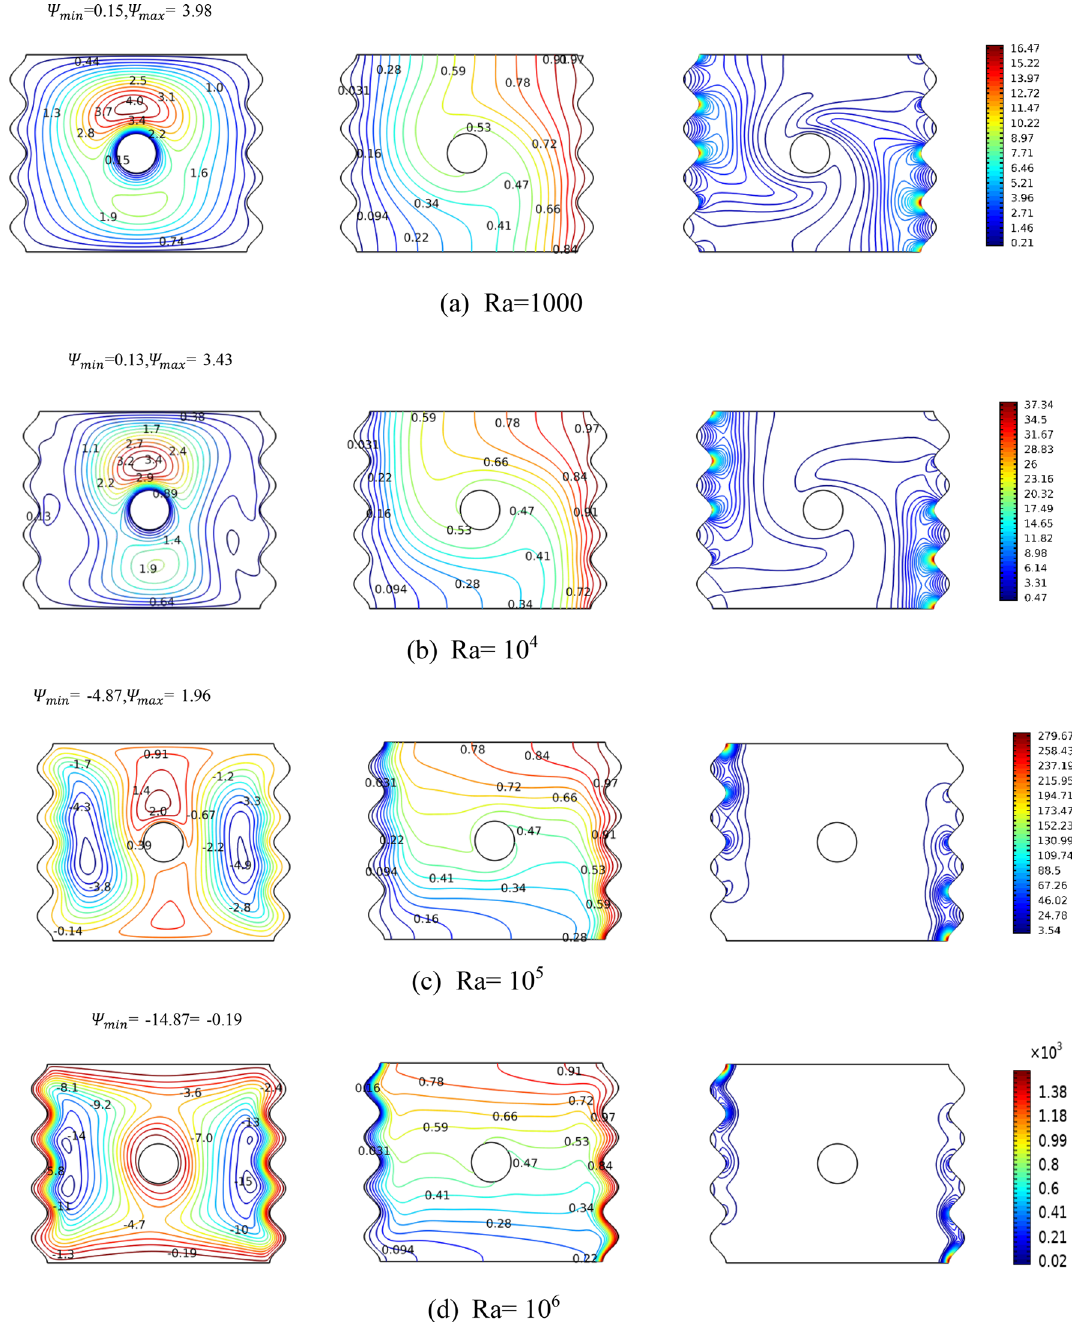
Figure 4. Streamlines, isotherms and isentropic variation by Ra for case, Ha = 25, Ω = 250. The panels represent the levels of the